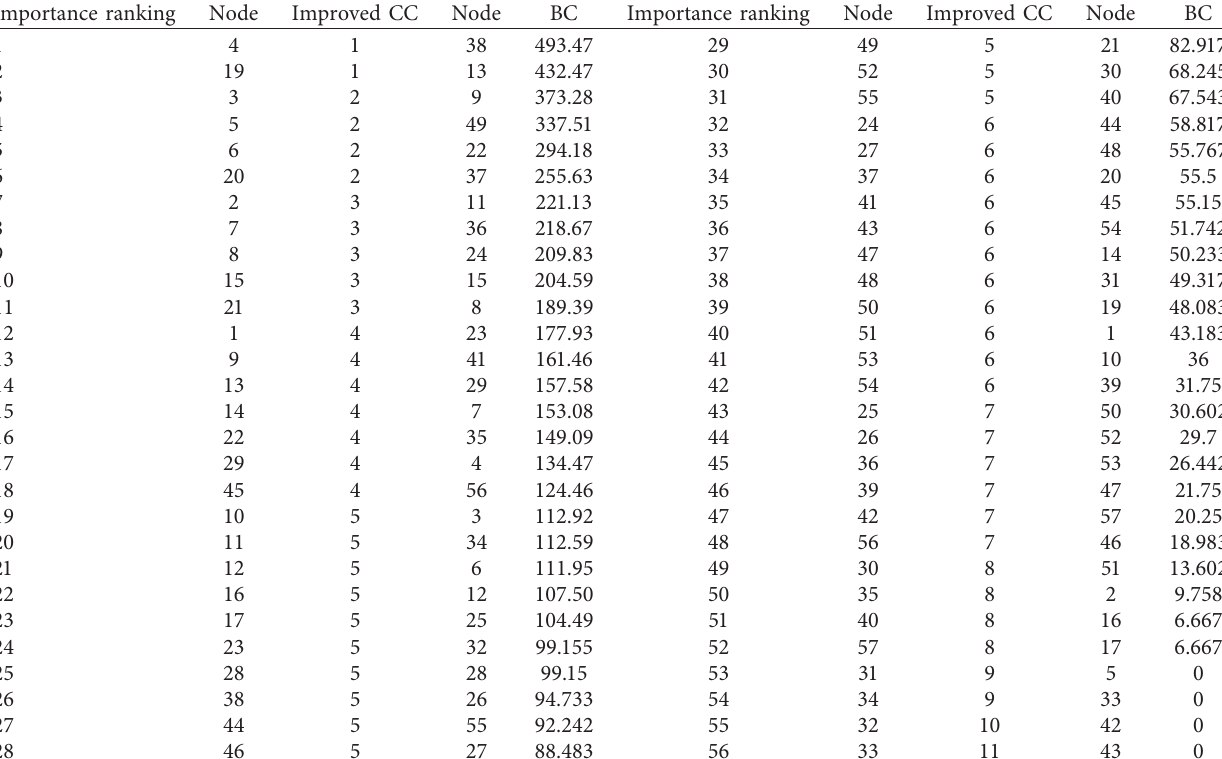
Table 1: Values of BC and improved CC under IEEE57 attacking the 18th